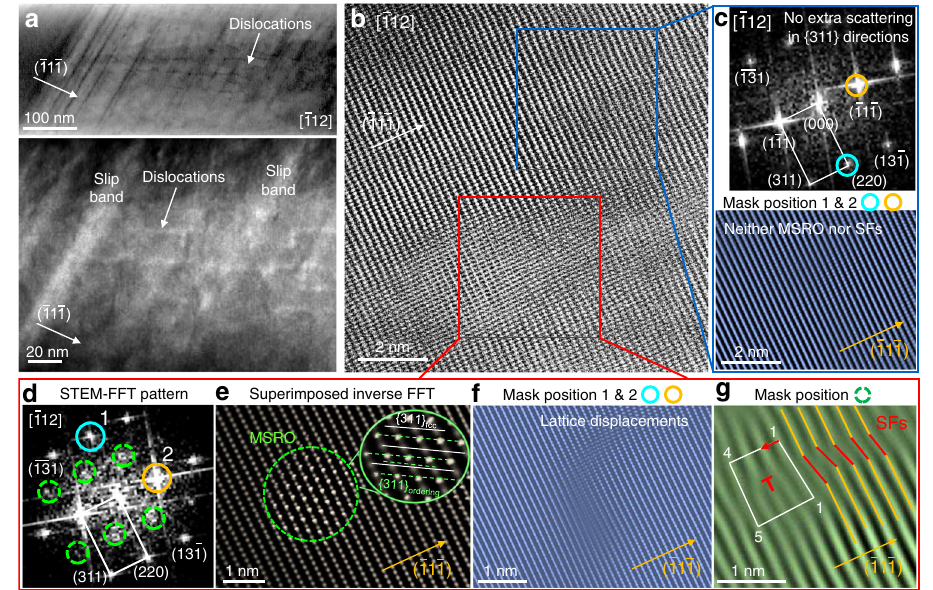
Fig. 4 | STEM analysis of the origin of mechanically driven SRO in the defor- mation structure. a STEM image (top) of HEA-M along the [ (cid:1) 112] zone axis and the corresponding enlarged annular dark- fi eld image (bottom), showing the glide of mobile dislocations across the pre-existing single slip lines and slip bands that are inclined tothe <011> directions onthe {111}planes. b STEM imageofoneslip band. c [ (cid:1) 112] STEM-FFT pattern (top column) and corresponding inverse FFT lattice fringes (bottom column), obtained from the undistorted area (blue box) in b , showing neither extra diffuse scattering nor SFs. d [ (cid:1) 112] STEM-FFT pattern obtainedfromthedistortedzoneofthelocallatticeintheredboxin b showingthe mechanicallydrivenSRO(MSRO)-derivedextradiscsatthe½{311}locations(green